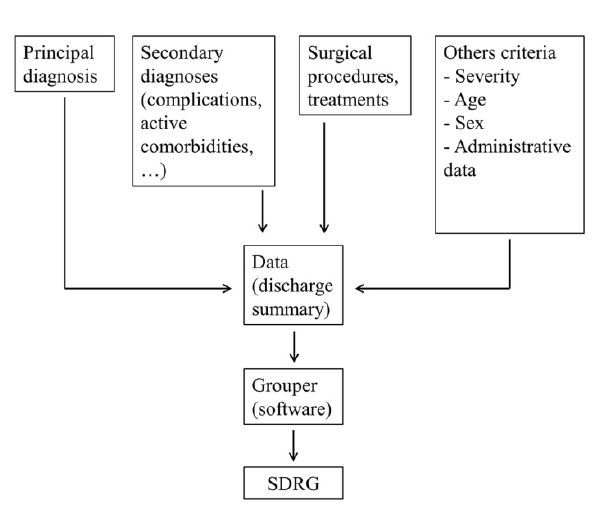
Figure 2. SDRG classification algorithm. (Adapted from